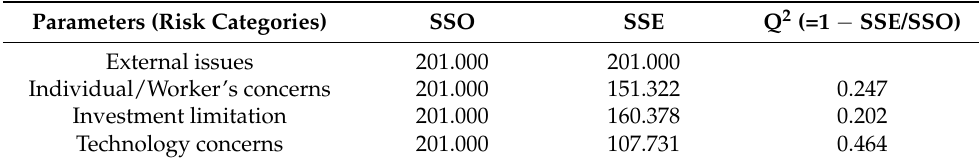
Table 8. Construct cross-validated redundancy (Q 2